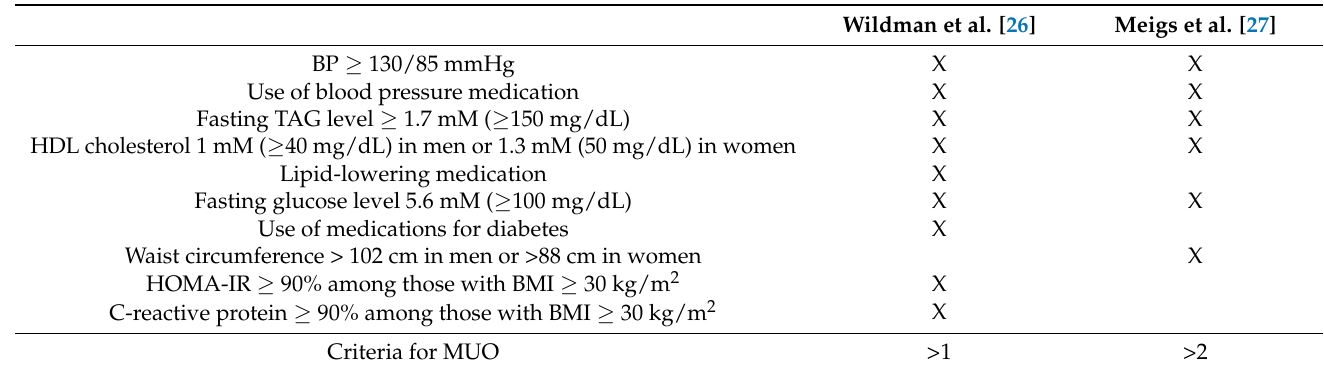
Table 4. Criteria for definition of metabolically healthy obese (MHO) and metabolically unhealthy obese (MUO)